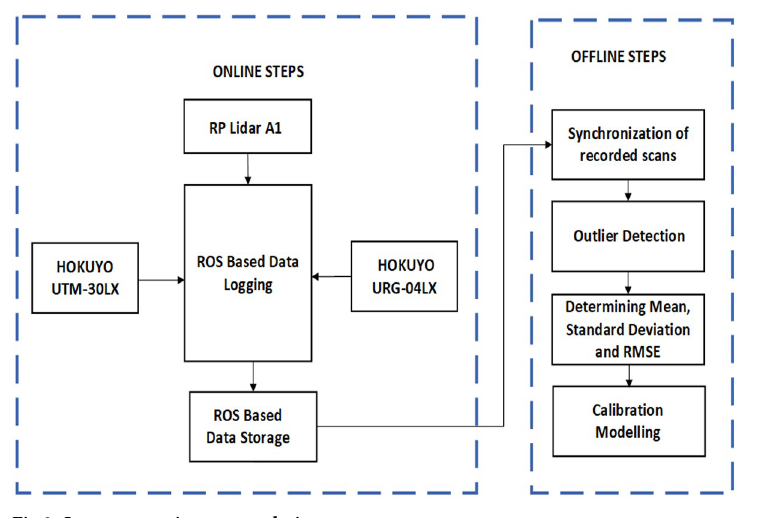
Fig 3. Instrumentation system